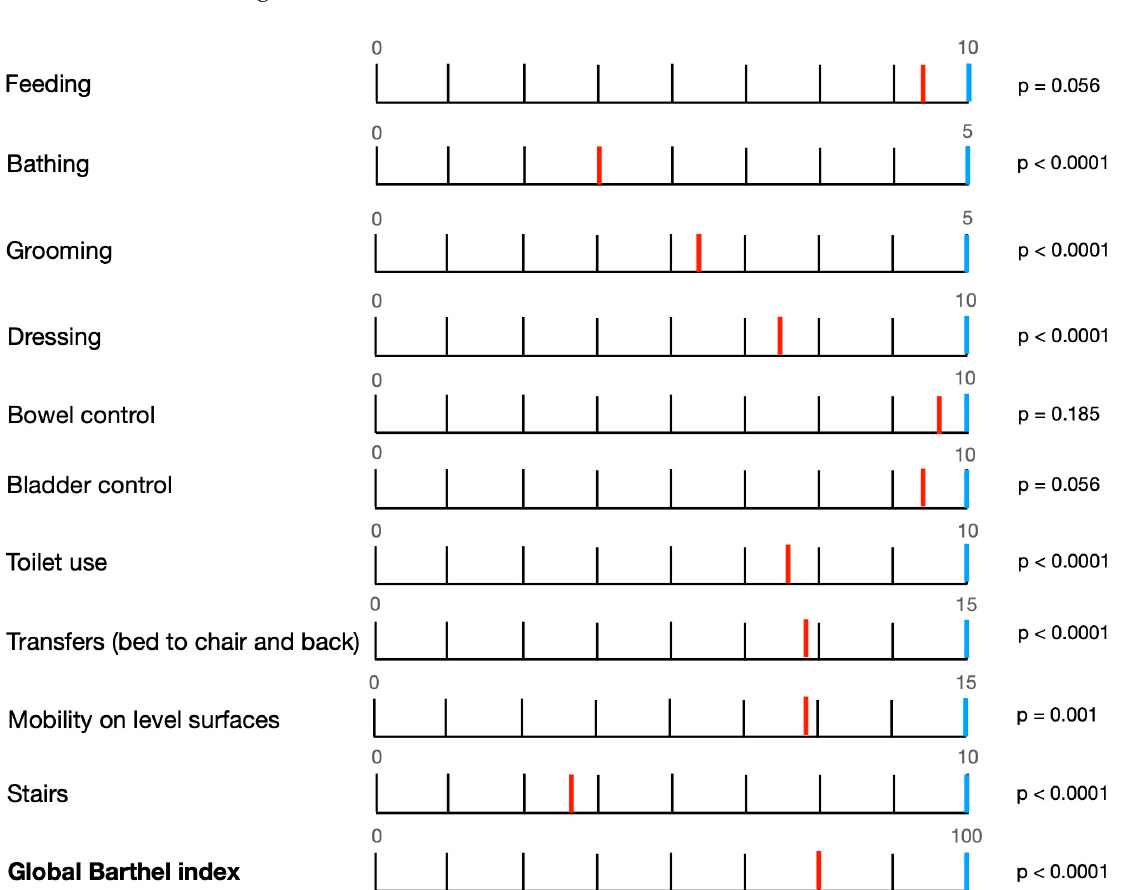
Figure 2. Temporal evolution of ADLs according to Barthel index. Temporal evolution of single activity of daily life (ADLs) comparing acute ADLs (red bar) and chronic ADLs (blue bar) with their specific statistical significance.